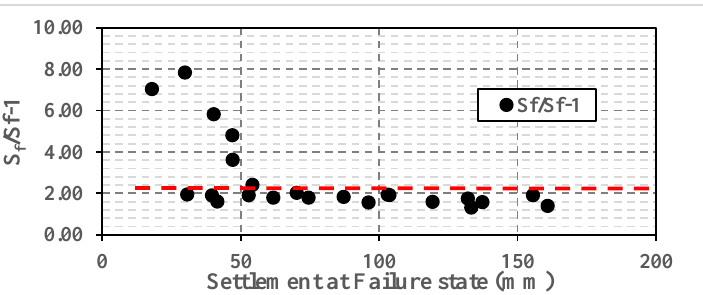
Figure 10. The ratio between the induced settlement at the failure load (S f ) and the settlement (S f-1 ) under the load before the last load increment (0.9Q ult ).